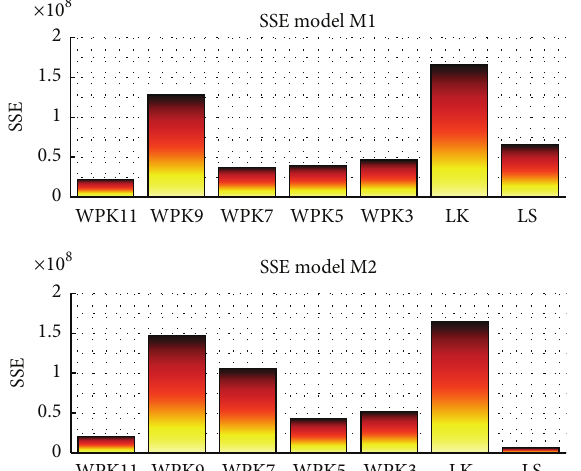
Figure 25: Comparison of the averaged values of the 𝑅 2 coefficient obtained by the regression of models M1 and M2 for all the tested dielectrics and insulation